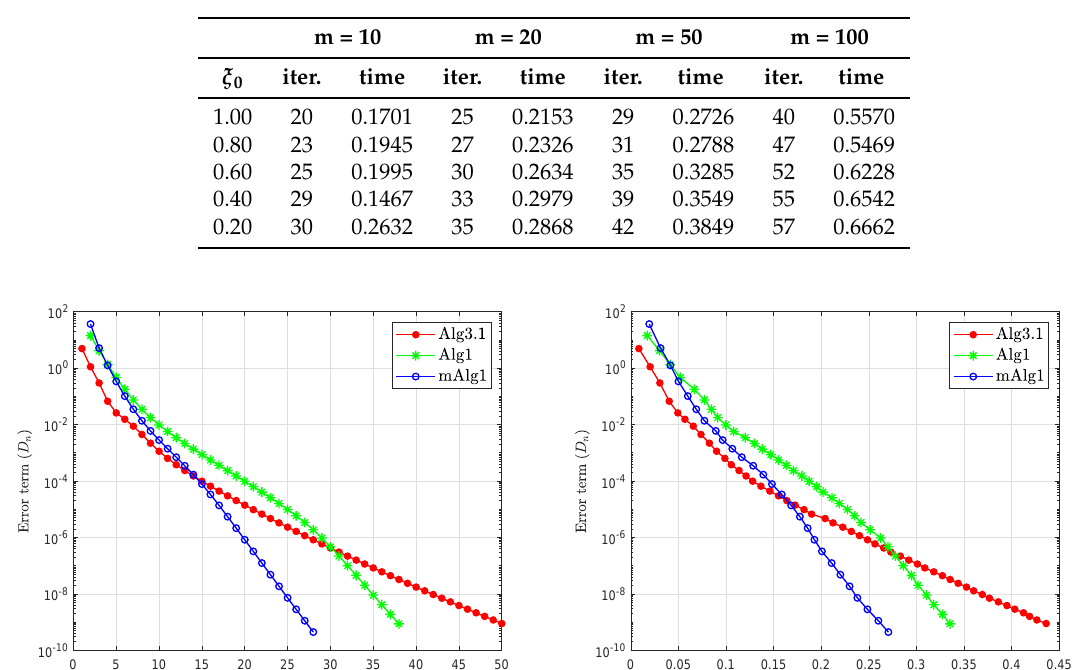
Table 1. Example 1: Algorithm 1 numerical behaviour by letting different options for ξ 0 and m.